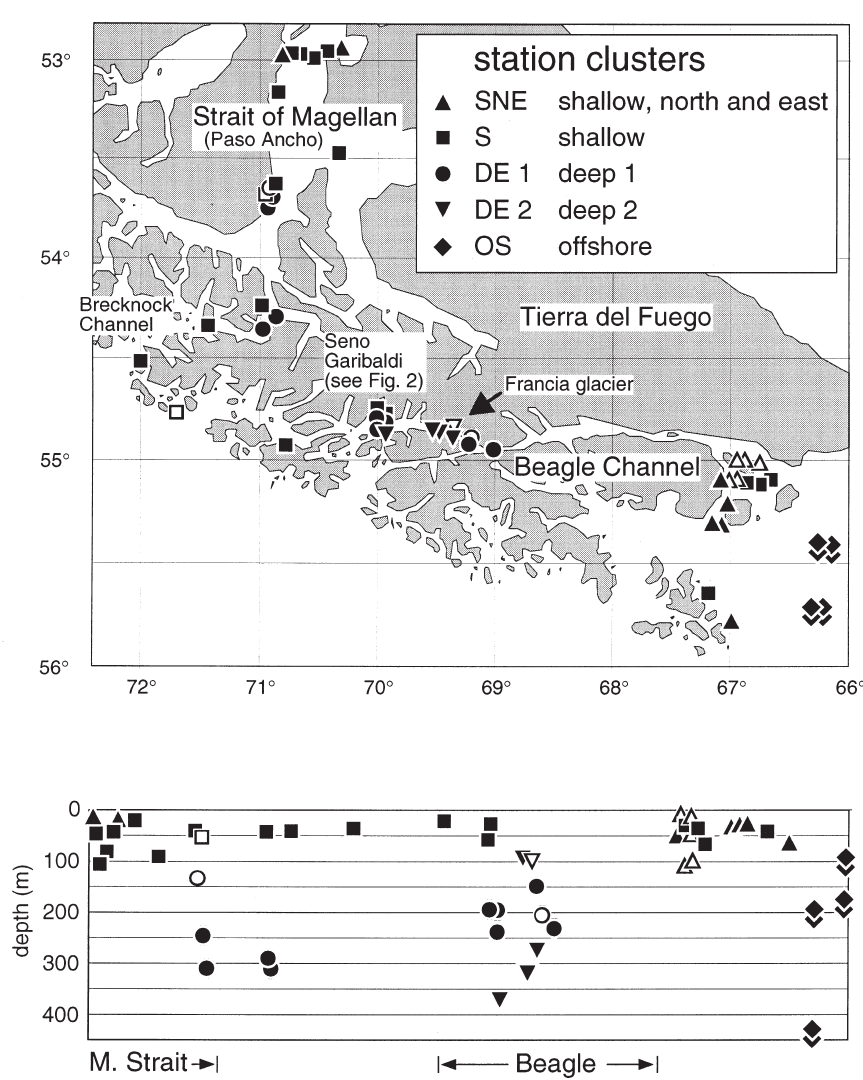
F IG . 1. – Station map. In the lower part stations are aligned (from left to right) along a transect starting at the northern part of Paso Ancho (Straits of Magellan) through the channel system east of Tierra del Fuego into the Beagle Channel and further east to the offshore stations south of the eastern mouth of the Beagle. Symbols represent different clusters according to cluster analysis. Open symbols indicate stations classified only by key